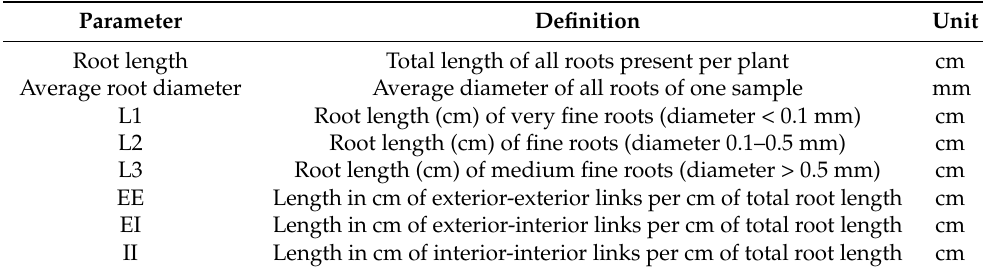
Table 2. Parameters used to define root morphology and link basic connectivity.